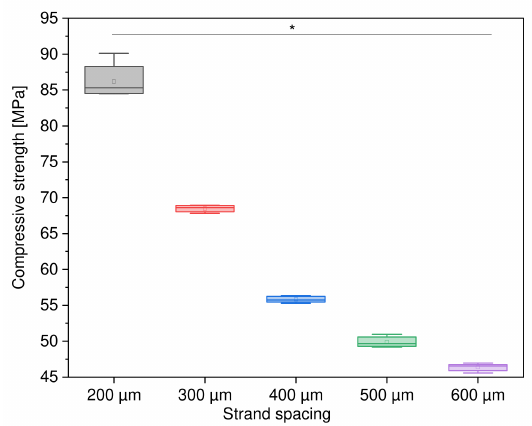
Figure 6. Compressive strength as a function of strand spacing; n = 30; p < 0.05 (*).